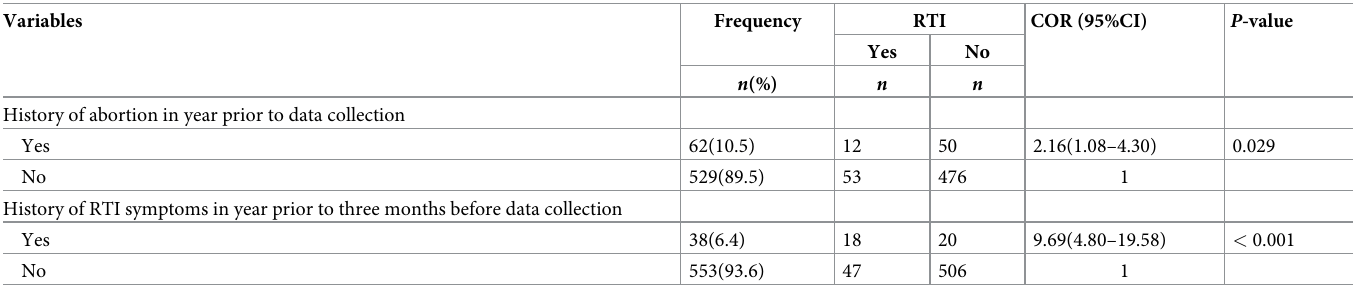
Table 3. History of comorbidities among reproductive age women in Dessie City, Ethiopia, January to March 2019.